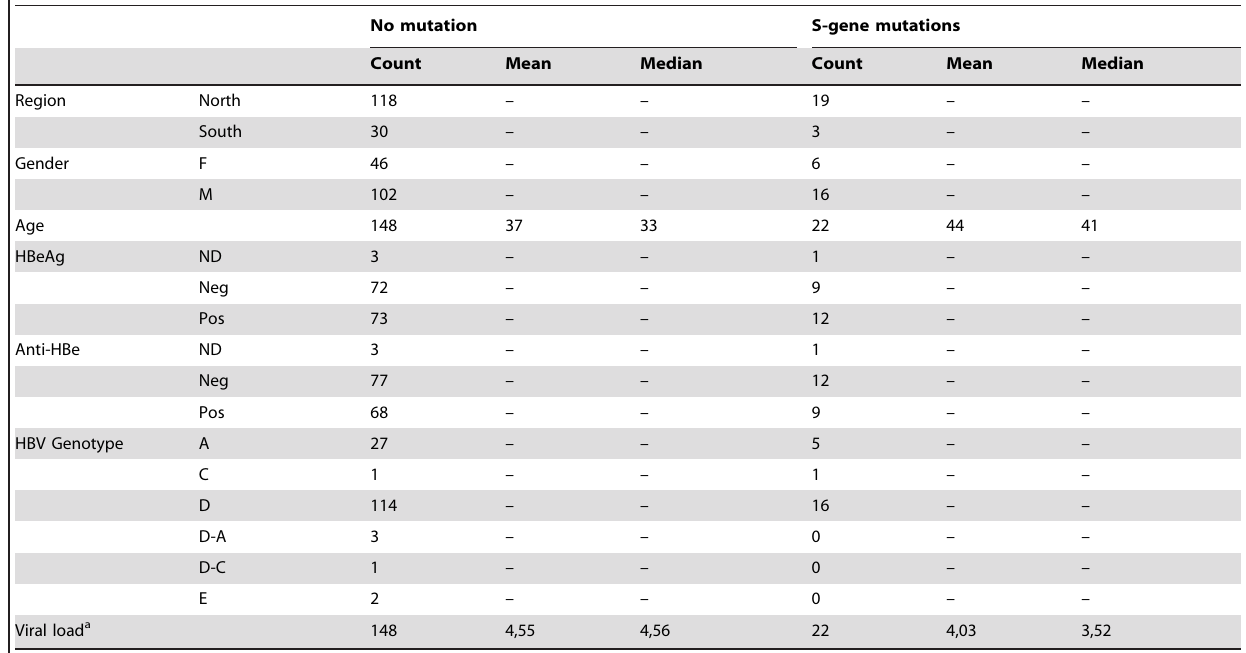
Table 4. Distribution of S-gene variants of Omani HBV